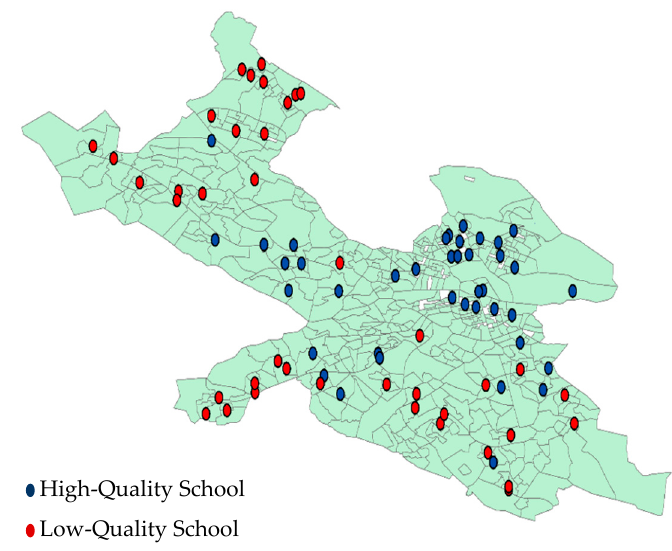
Figure 2. High and low-quality schools based on Measure 2.